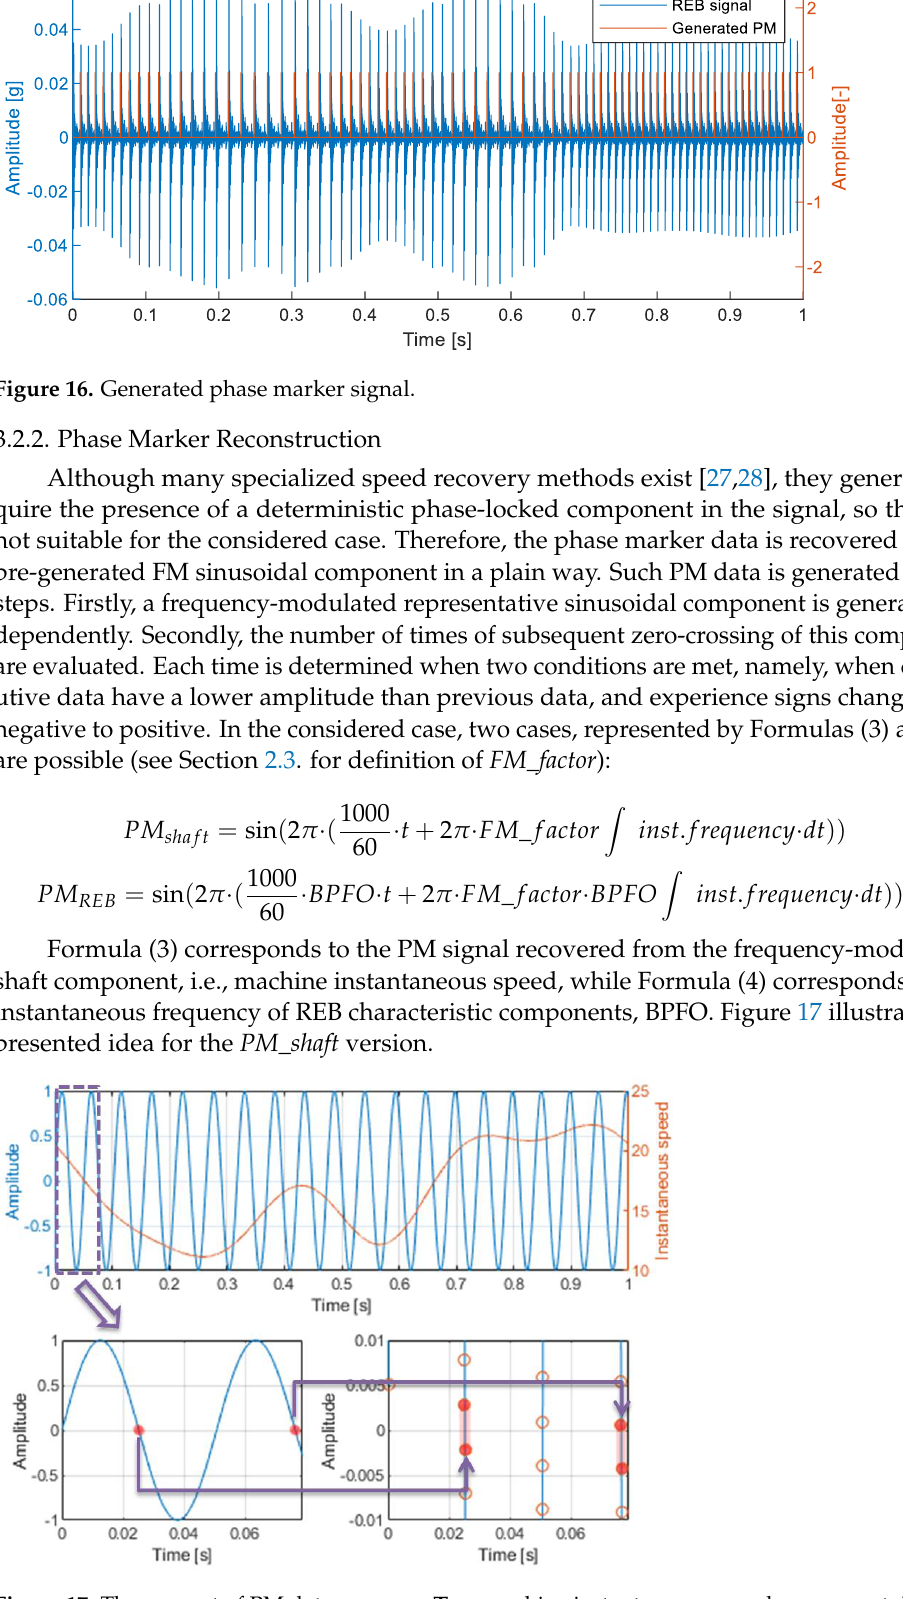
Figure 17. The concept of PM data recovery. Top: machine instantaneous speed component. Bottom left: first full rotation. Bottom right: data points used in PM calculations.